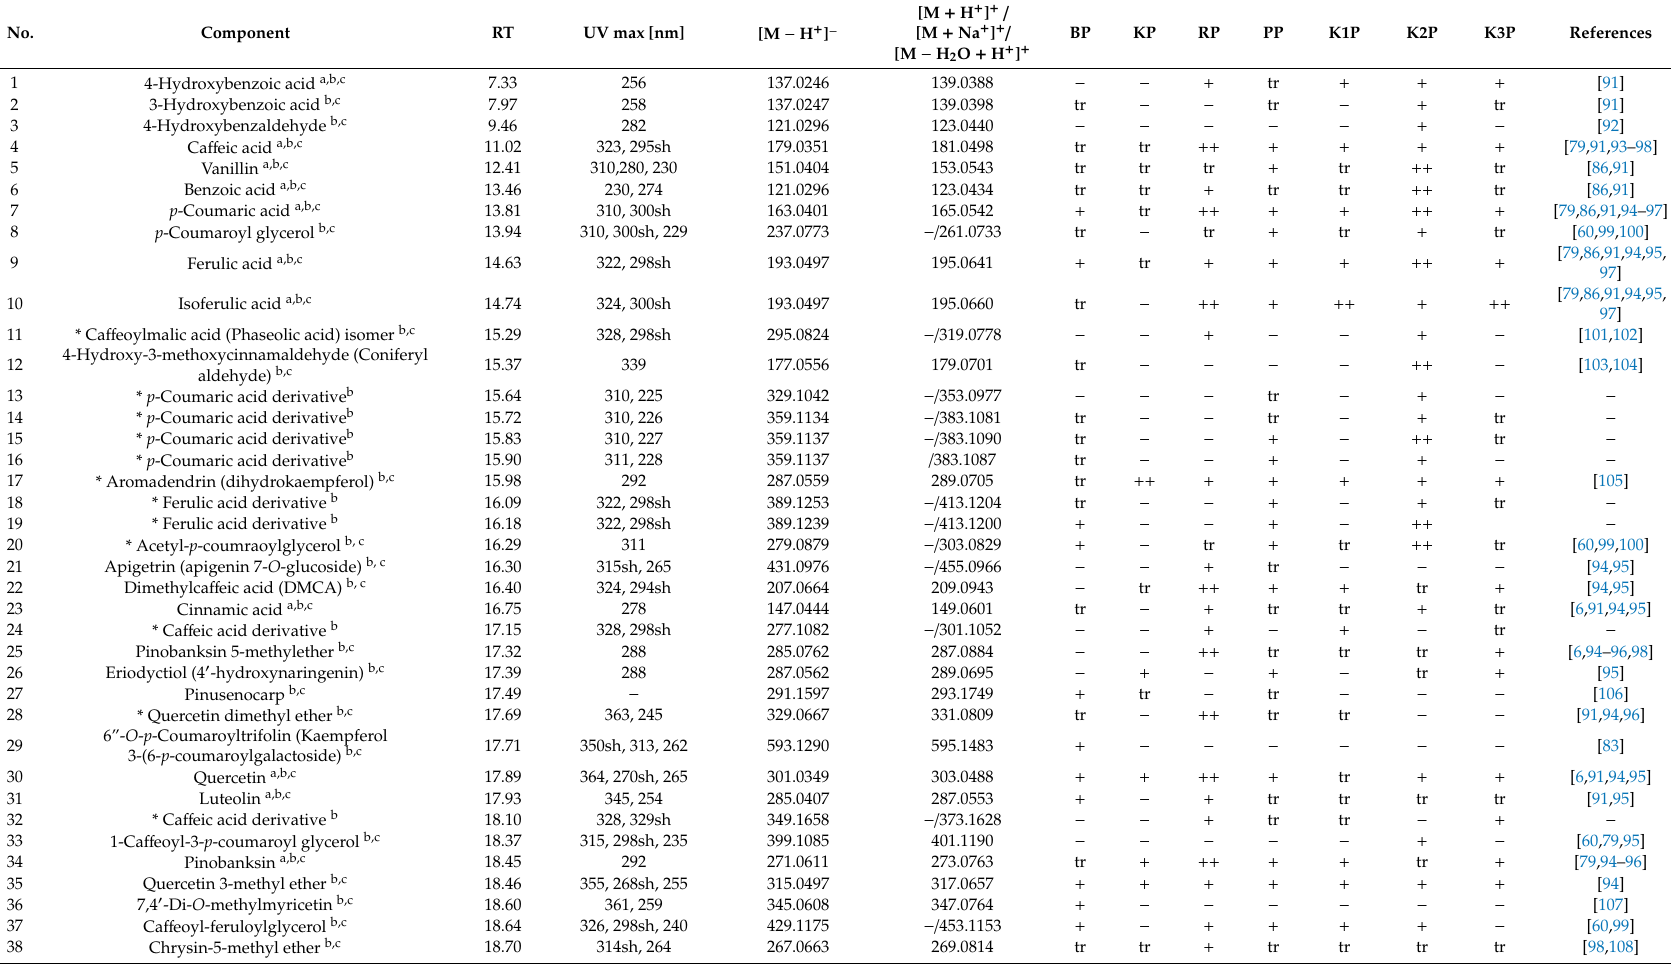
Table 3. Compounds identified by ultra high performance liquid chromatography with diode array detector and quadrupole time-of-flight mass spectrometry (UHPLC-DAD-QqTOF-MS) in extracts of Croatian propolis